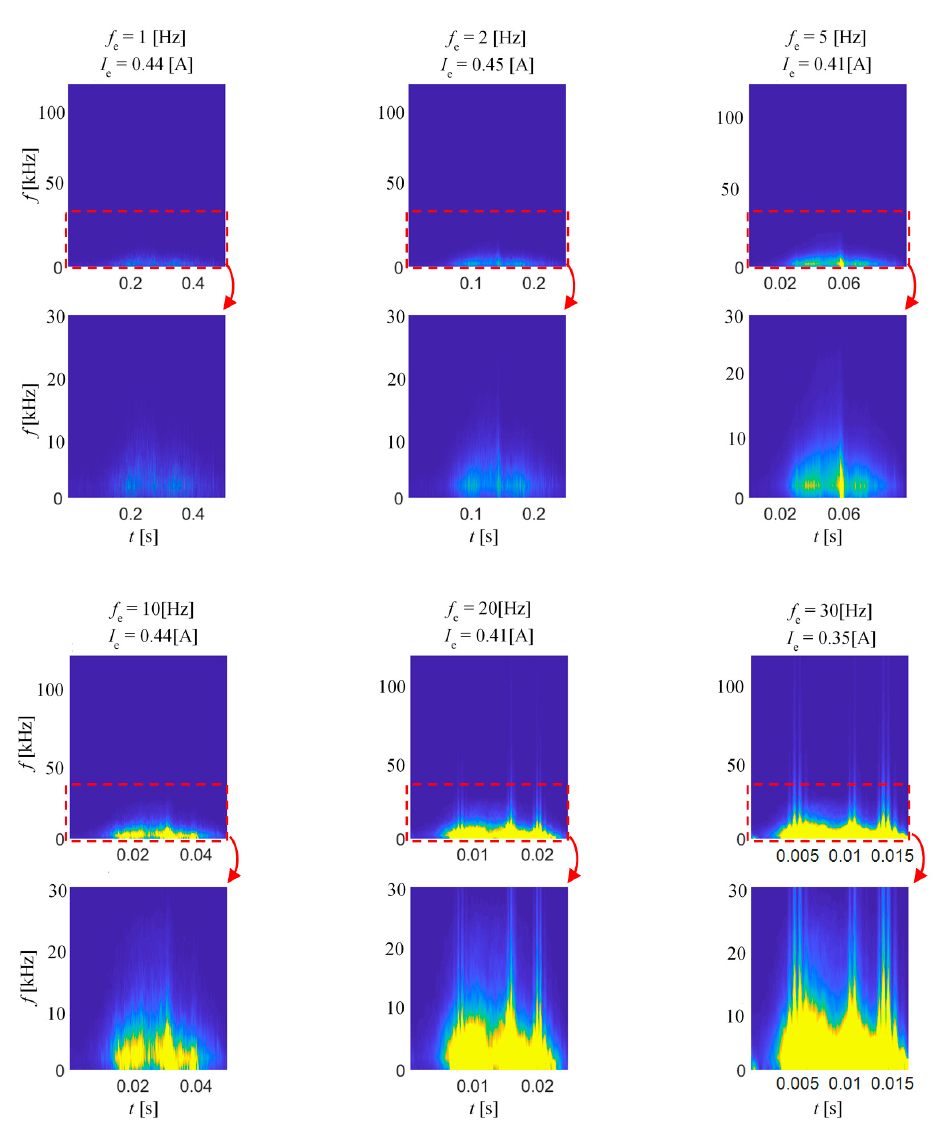
Figure 6. BN TF_S spectrograms obtained for various excitation frequency and constant excitation voltage amplitude; view of the full frequency range (top) along with the close-up up 30 kHz.